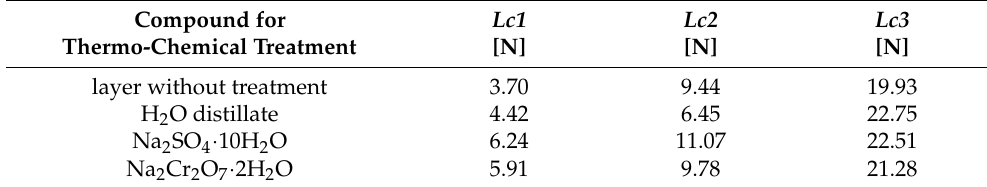
Figure 4. Critical loads determined for layers: ( a ) Sample 1, ( b ) Sample 2, ( c ) Sample 3, ( d ) Sample 4; Lc1 -Hertz cracks, Lc2 -cohesive cracks and Lc3 -adhesive cracks and complete damage of layer. Table 5. Critical loads demonstrated for studied layers. Table 5. Critical loads demonstrated for studied layers.